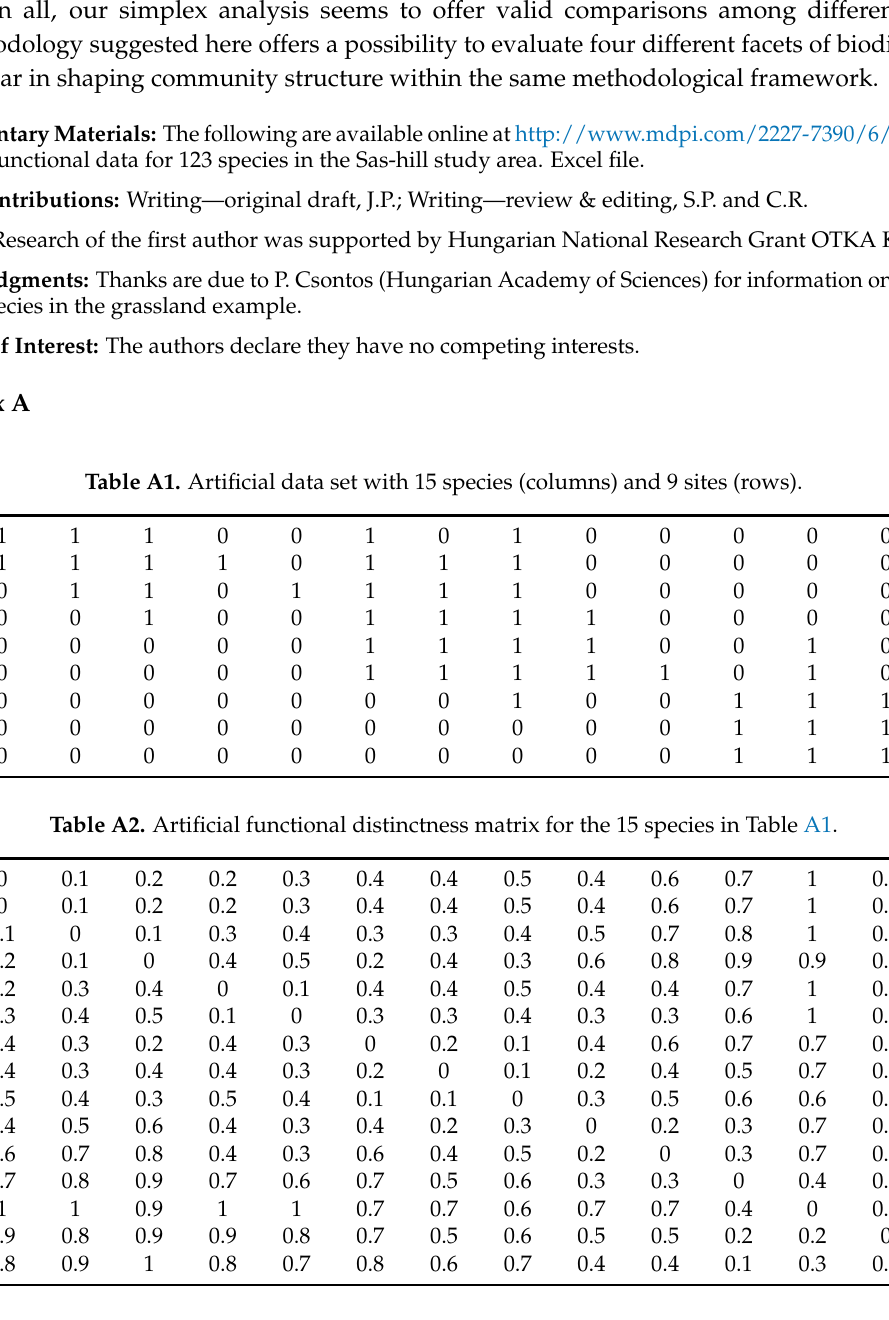
Table S1: Functional data for 123 species in the Sas-hill study area. Excel file.